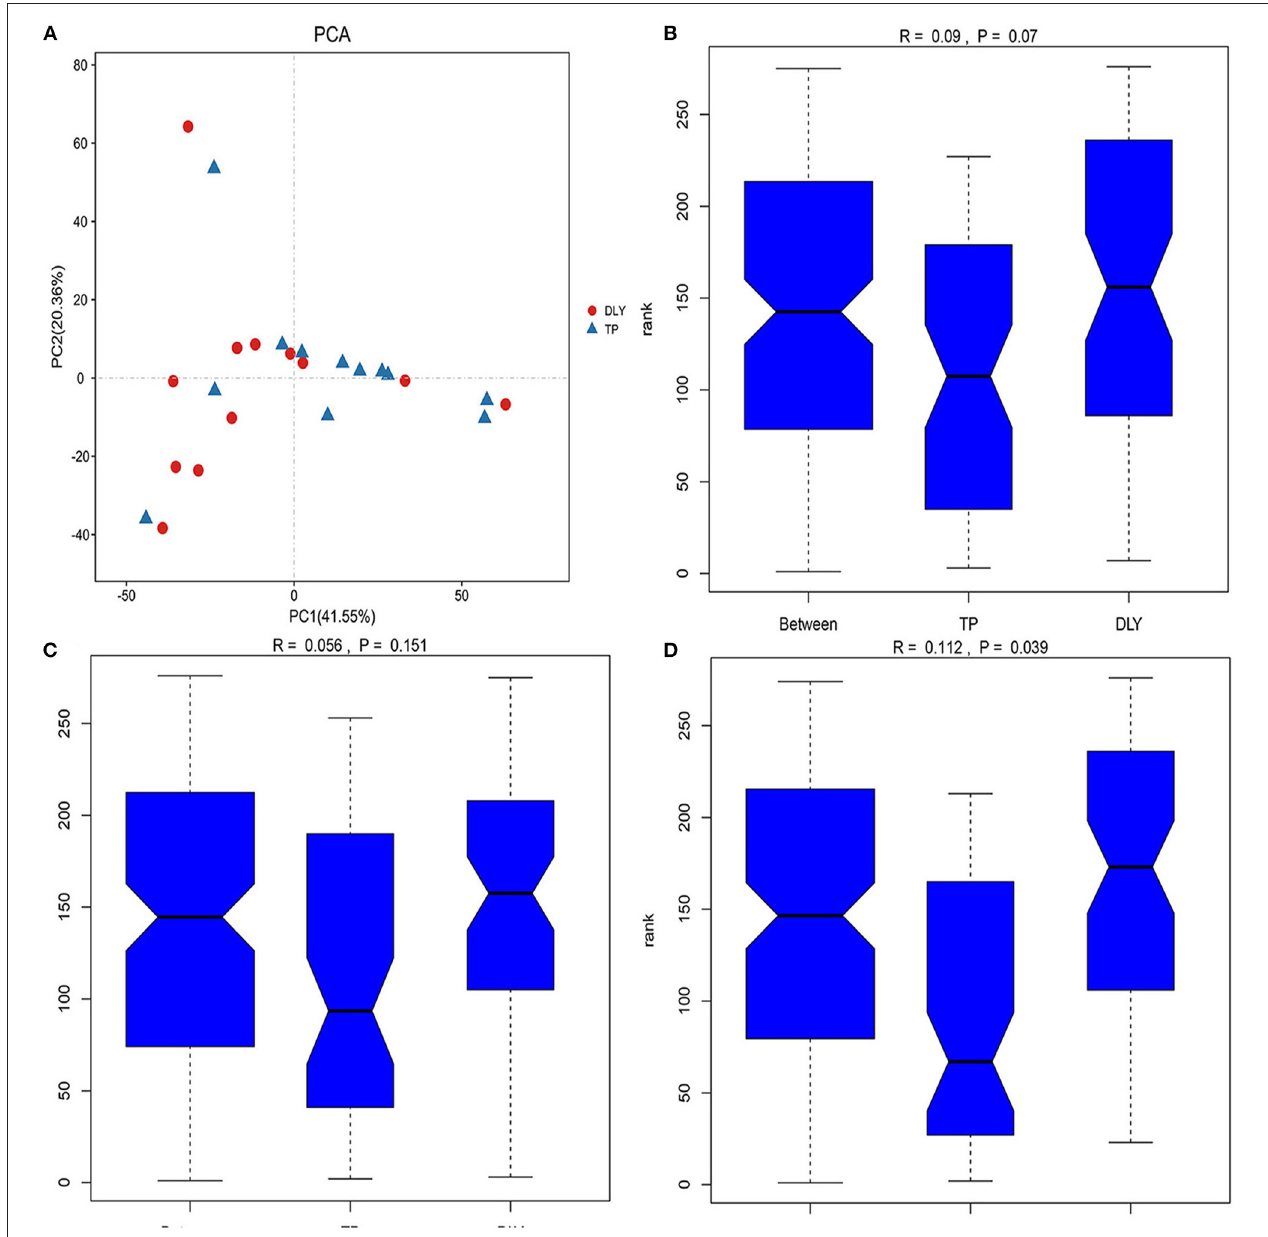
FIGURE 2 | Beta-diversity analysis of jejunal microbiota between TP and DLY pigs. (A) PCA analysis; (B) ANOSIM analysis at the OTU level; (C) ANOSIM analysis at the phylum level; (D) ANOSIM analysis at the genus